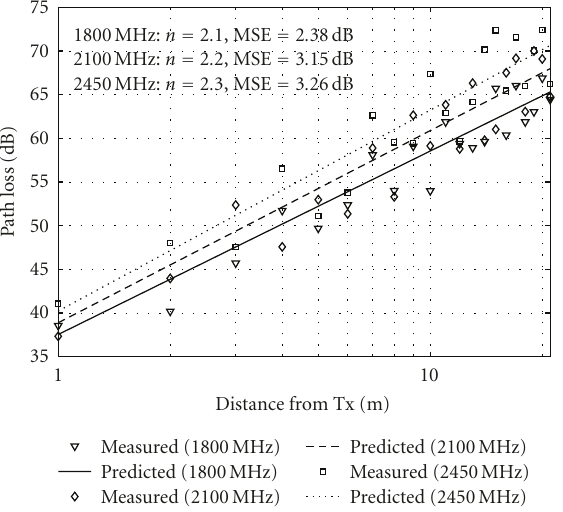
Figure 6: Path loss model results at the three frequency bands along the aisle of the